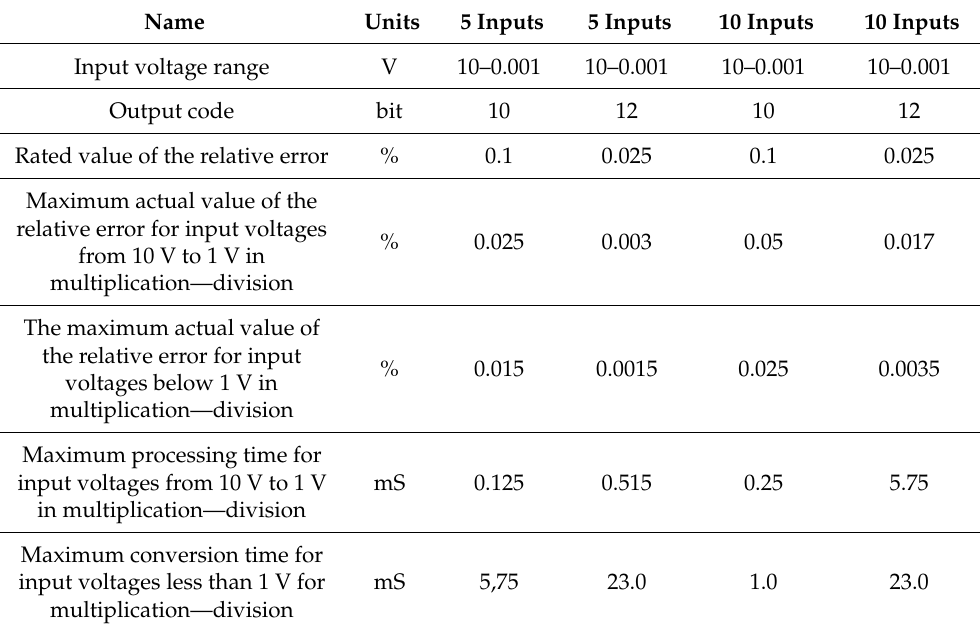
Table 1. Summary of the results of modelling of multi-input multifunctional